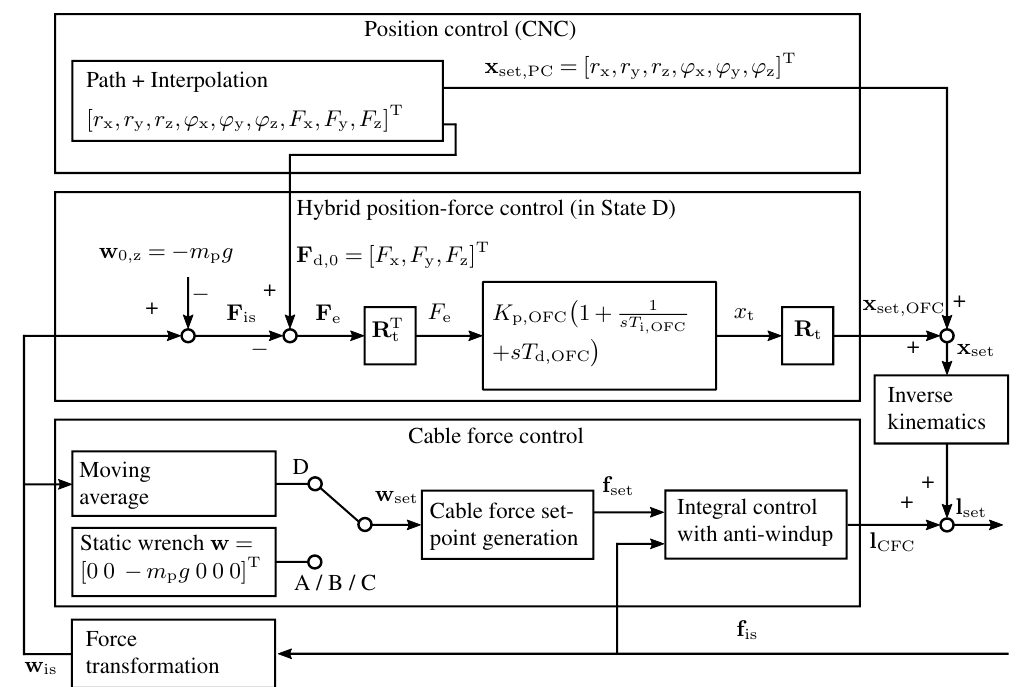
Figure 5. Proposed implementation of the hybrid position-force control with cable force control.